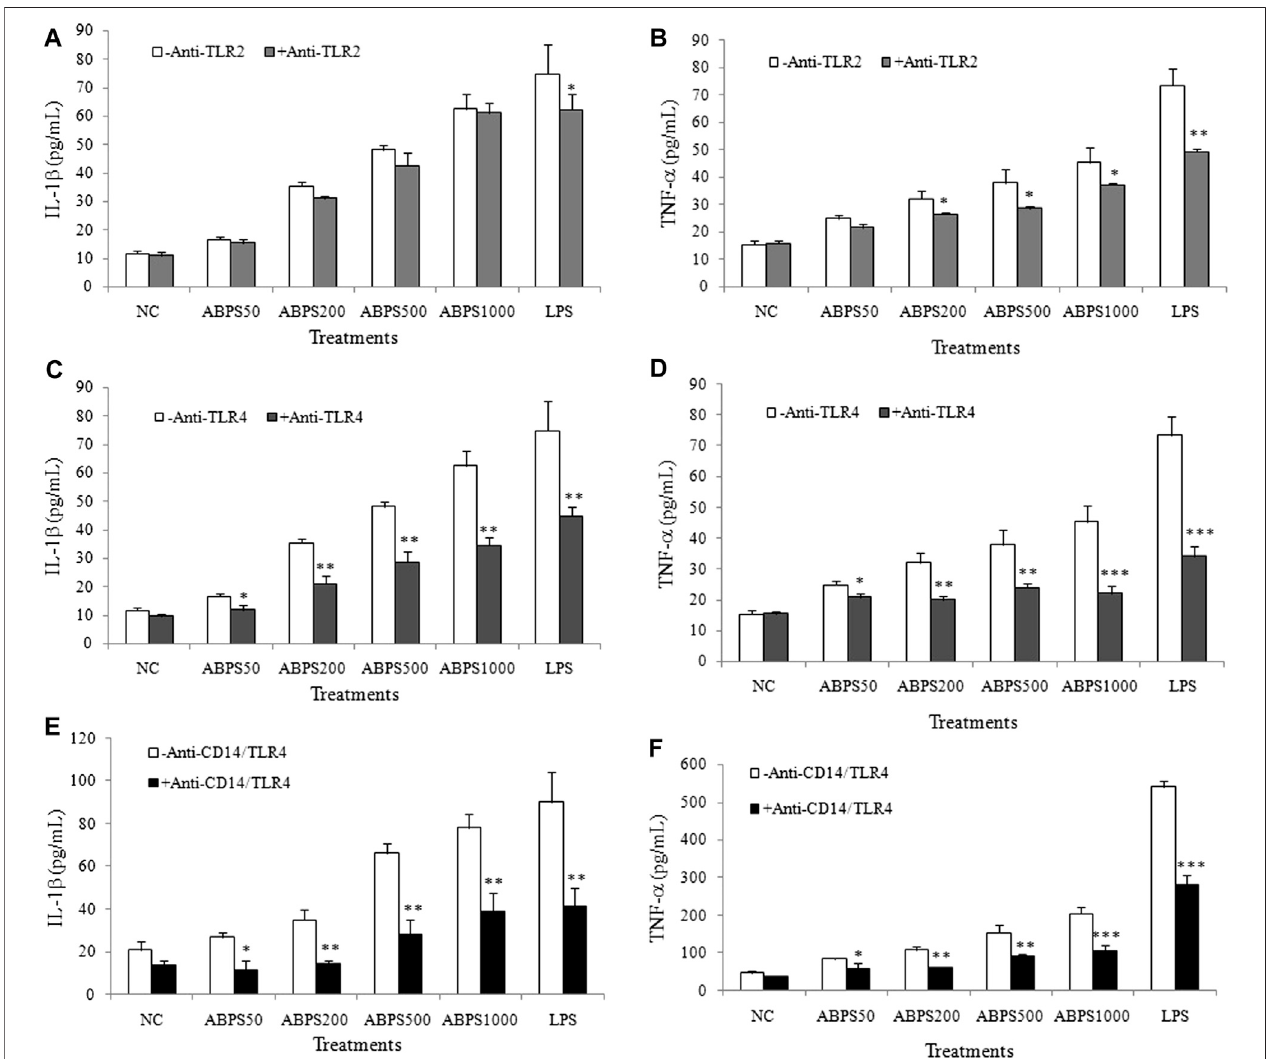
FIGURE3| ABPSactivationofmacrophagesdependsonTLR4. (A) IL-1 β and (B) TNF- α .Thecellswerepretreatedwithorwithout20 μ g/mlanti-TLR2antibodyfor 1 hand then treatedwith ABPS(0, 50,200,500,and 1,000 μ g/ml,respectively)orLPS (5 μ g/ml) for24 h. Cellculture medium wascollected,and thesecretion levelsof cytokinesweredetected. (C) IL-1 β and (D) TNF- α .Cellswerepretreatedwithorwithout20 μ g/mlanti-TLR4antibody. (E) IL-1 β and (F) TNF- α .Cellswerepretreatedwith or without 20 μ g/ml anti-CD14/TLR4 antibody. NC: normal control; ABPS50: 50 μ g/ml ABPS treated; ABPS200: 200 μ g/ml ABPS treated; ABPS500: 500 μ g/ml ABPS treated; ABPS1000: 1,000 μ g/ml ABPS treated; and LPS: 5 μ g/ml LPS treated (positive control). * p < 0.05, ** p < 0.01, *** p < 0.001 vs. control (without antibody treatment group). The values are presented as means ± SD.